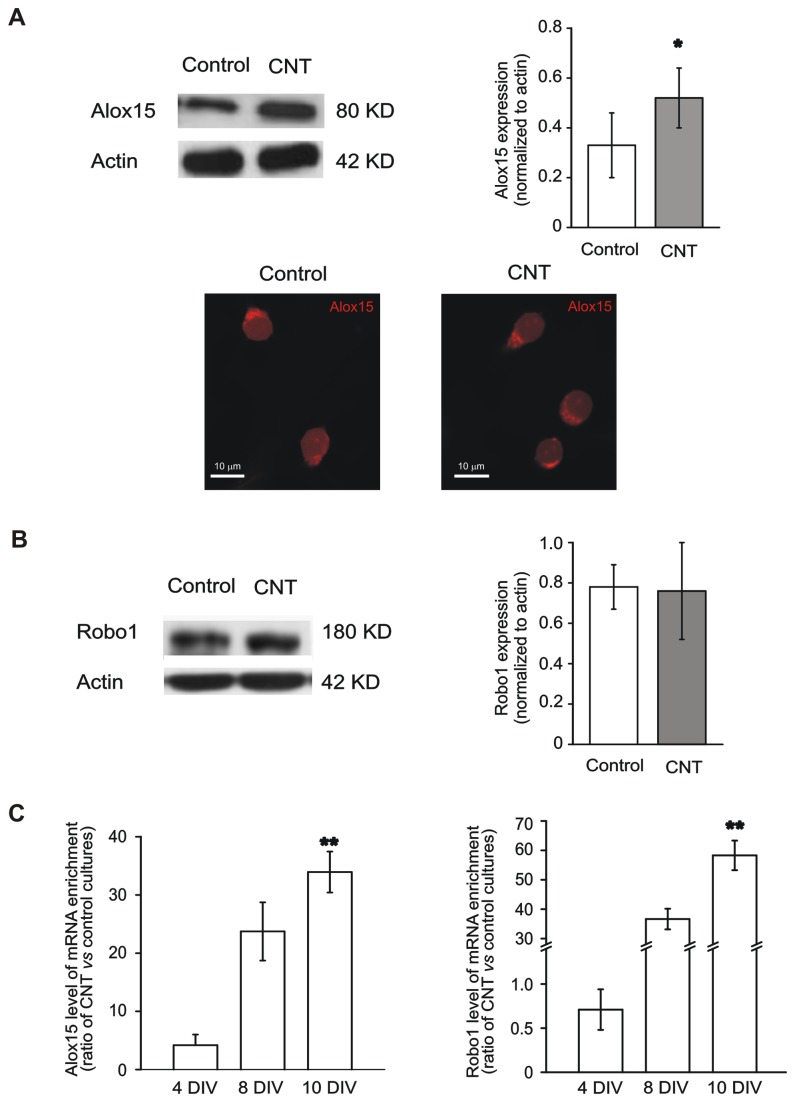
The expression of Alox15 and Robo1 is increased by MWCNT substrate.(A) Top left, Western blot analysis of the Alox15 protein (migrated at approximately 80 KD) isolated from control (left lane) and CNT (right lane) spinal cultures, showing the strong increase in Alox15 expression in CNT cultures. Top right, quantification of the Alox15 protein level normalized against actin. Bottom, confocal images of control and CNT neurons, stained using the anti-Alox15 antibody. Note the punctate appearance of strongly Alox15-immunopositive cytoplasmatic structures in both culturing conditions. (B) Left, Western blot analysis of the Robo1 protein (migrated at approximately 180 KD) from control (left lane) and CNT (right lane) cultures. Robo1 expression level is unaffected by the MWCNT substrate (right). (C) Time course of Alox15 (left) and Robo1 (right) expression levels by transcript-specific real time PCR in CNT cultures normalized to control. The expression of both proteins is progressively upregulated in CNT cultures during in vitro development.